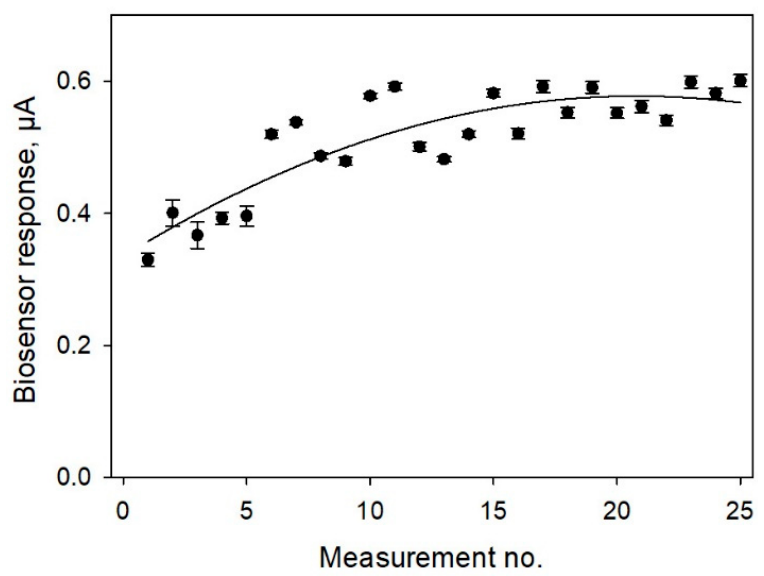
Figure 9. Operational stability of SPE/PEDOT:PSS/graphene/Nafion/ G. oxydans biosensor. Concen- tration of glucose in the measuring cell, 0.3 mM.